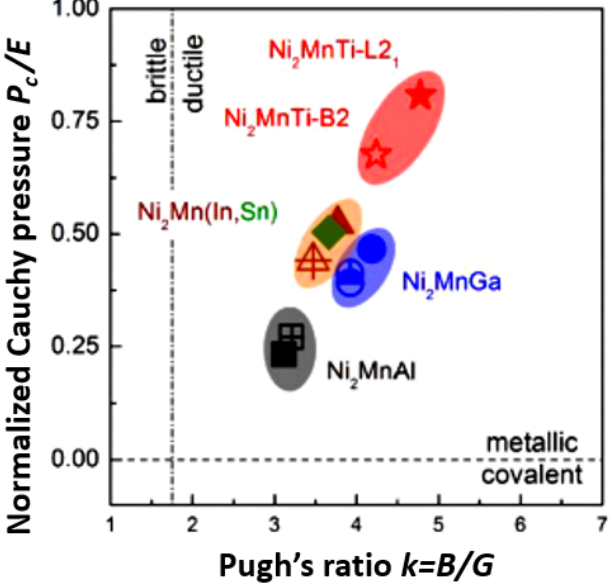
Figure 7. Ductile-brittle diagram of some conventional Ni – Mn – Z (Z = Ga, Al, In and Sn) and stoichiometric Ni 2 MnTi alloys. The horizontal dashed and the vertical dashed dot lines indicate Pettifor’s and Pugh’s brittleness–ductility criteria, respectively. The inhibition of covalent p–d hybridization obtained by removing the p- group atom is supported by this result. Reproduced with permission from ref. [79]. Copyright 2019 Elsevier.